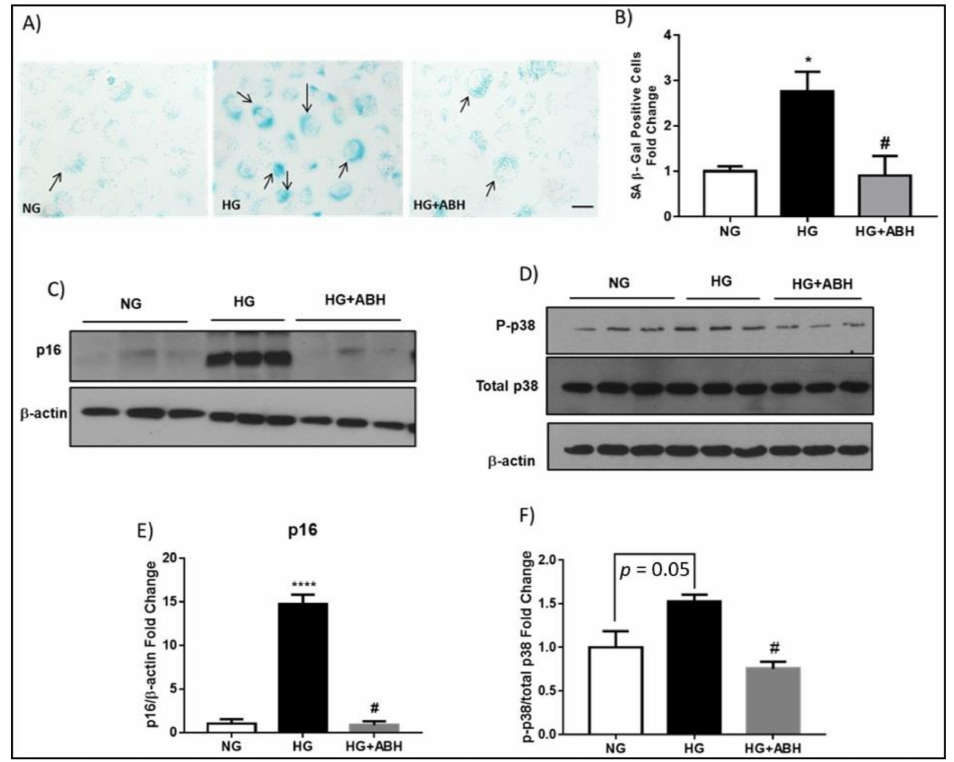
Figure 7. High glucose-induces endothelial cell senescence. ( A ) Senescence associated β -Gal activity (black arrows) and quantification ( B ) showing a significant increase in SA β -Gal positive cells with high glucose (HG, 25 mM) treatment when compared to normal glucose (NG, 5 mM). ABH treatment prevented this increase. * p < 0.05 vs. NG. # p < 0.05 vs. HG. n = 3. Scale bar = 50 µ M; ( C ) Western blot analysis with quantification ( E ) showing increased p16 INK4A expression in HG treated bovine retinal endothelial cells (BRECs) as compared to NG. Arginase inhibition with ABH blocked this increase. **** p < 0.0001 vs. NG. # p < 0.0001 vs. HG. n = 3. Experiments were repeated at least twice in independent batches of cells. Data are presented as a fold change of the NG; and, ( D ) Western blot analysis with quantification ( F ) showing increased phosphorylation of p38 in HG treated BRECs as compared to NG. Arginase inhibition with ABH significantly blocked this increase. # p < 0.05 vs. HG. n = 3. Experiments were repeated at least twice in independent batches of cells. Data are presented as a fold change of the